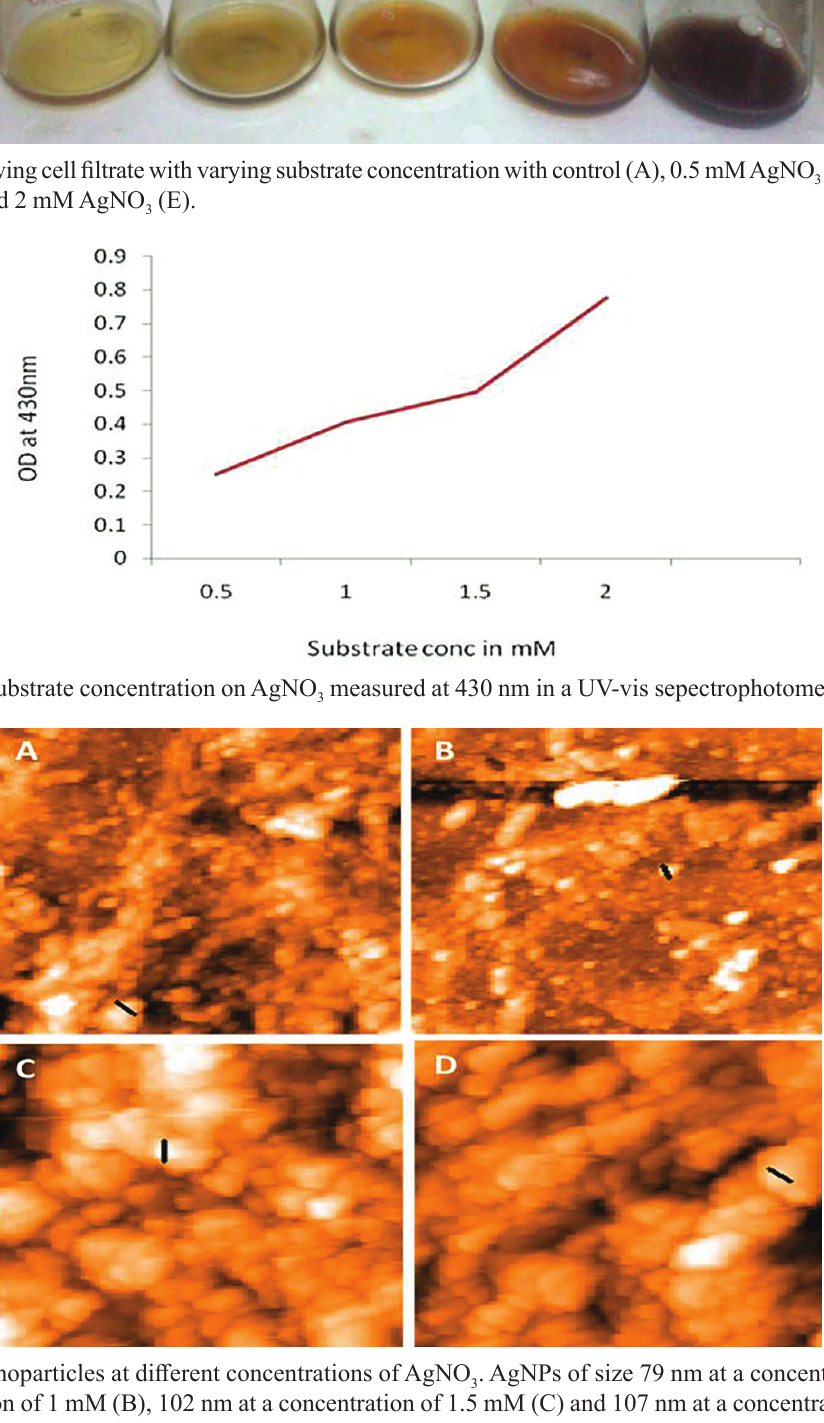
FIGURE 5 - Size of nanoparticles at different concentrations of AgNO 88 nm at a concentration of 1 mM (B), 102 nm at a concentration of 1.5 mM (C) and 107 nm at a concentration of 2 mM